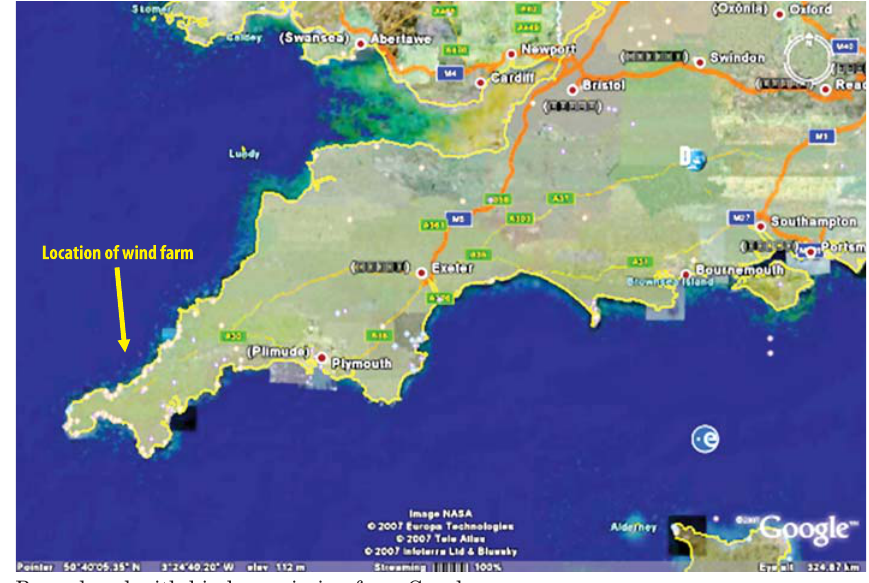
Figure 4. Location of Bears Down wind farm in North